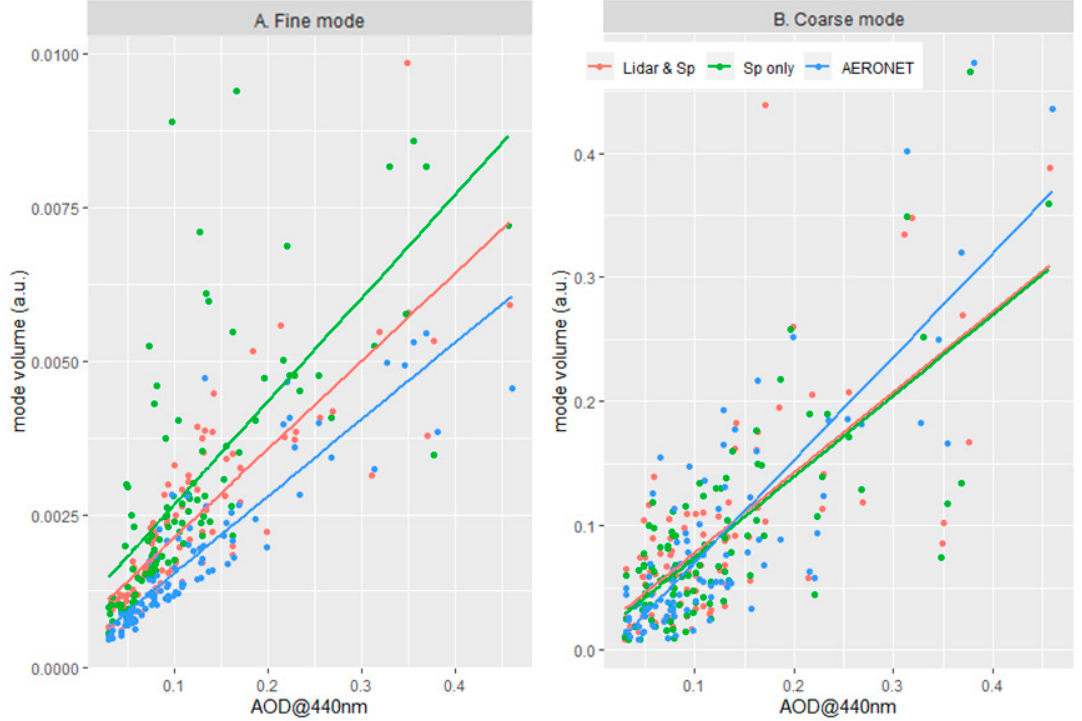
Figure 7. Volume area versus AOD @ 440 nm for the ( A ) fine and ( B ) coarse modes of the di ff erent schemes and their linear fit.